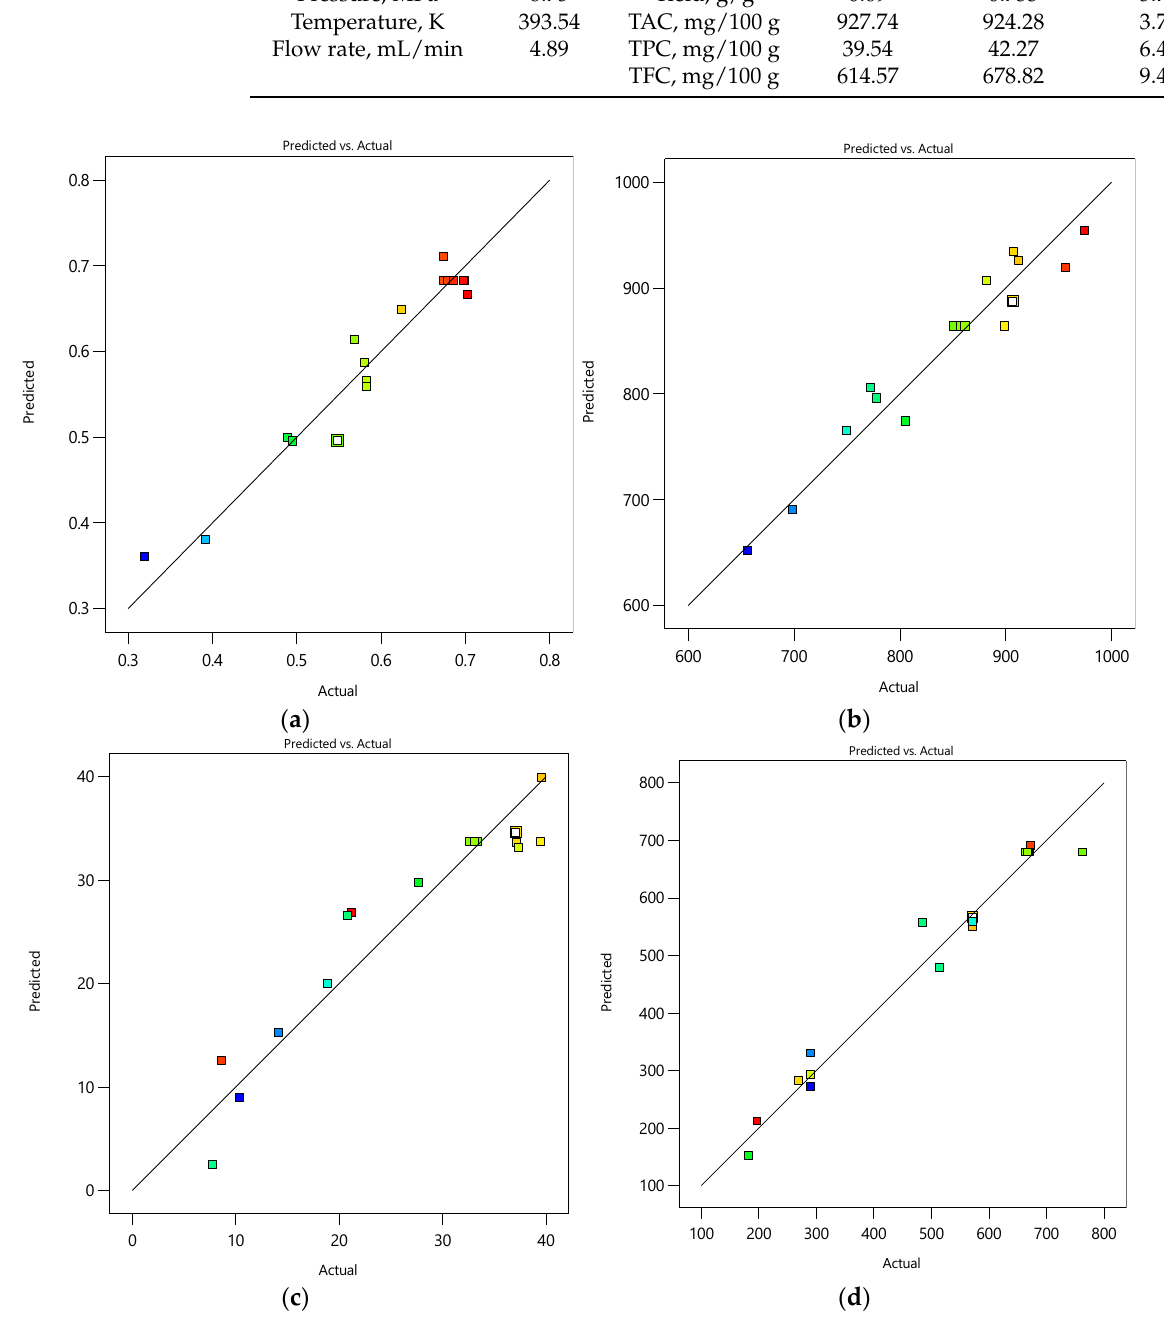
Figure 2. Predicted vs. actual responses in SWE: ( a ) yield, ( b ) TAC, ( c ) TPC, and ( d ) TFC. (Different colour of figure means to number of experiments).